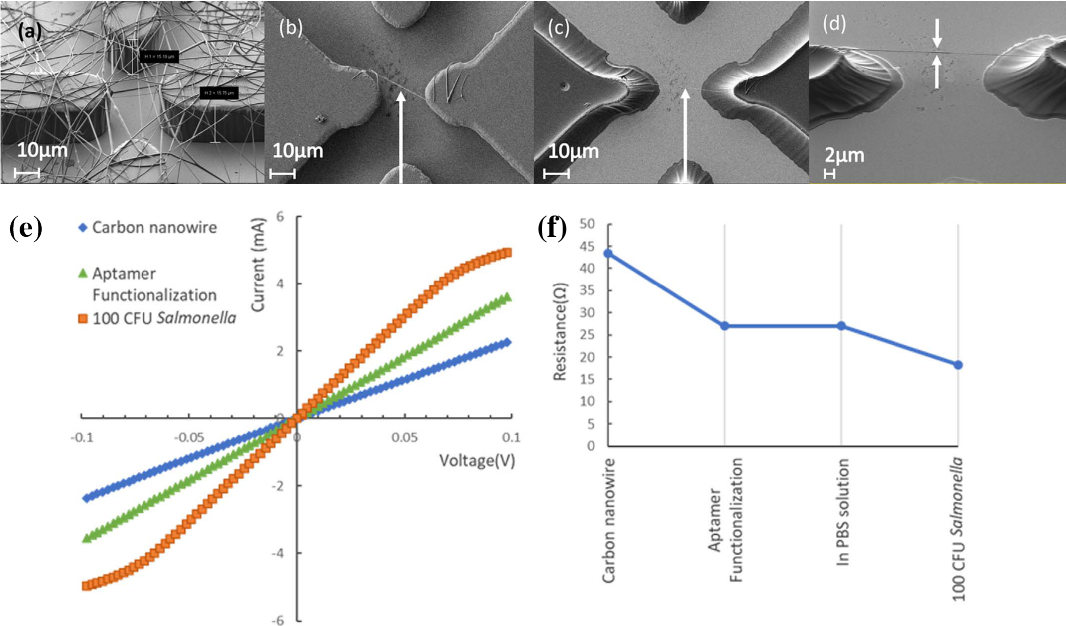
Figure 3. ( a ) SU8 photoresist electrode structure with electrodeposited SU8 photoresist